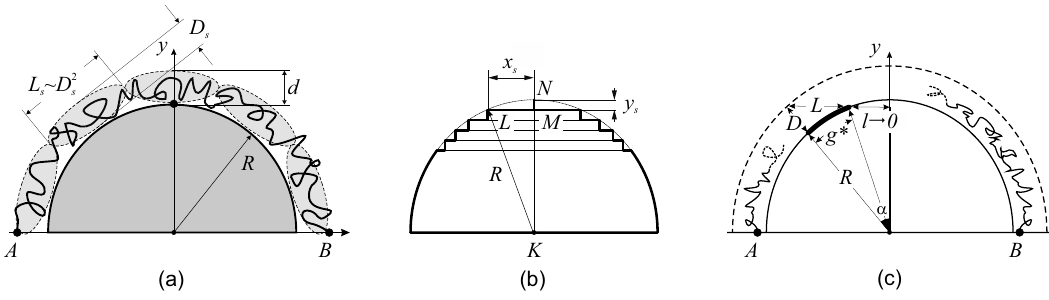
Figure 8 . (a) Two-dimensional random walk evading the semicircle. Dashed “elliptic blobs” of longitudinal size L 2 /a designate uncorrelated parts of a path; (b-c) Auxiliary geometric s ∼ D s constructions for (B.36) and